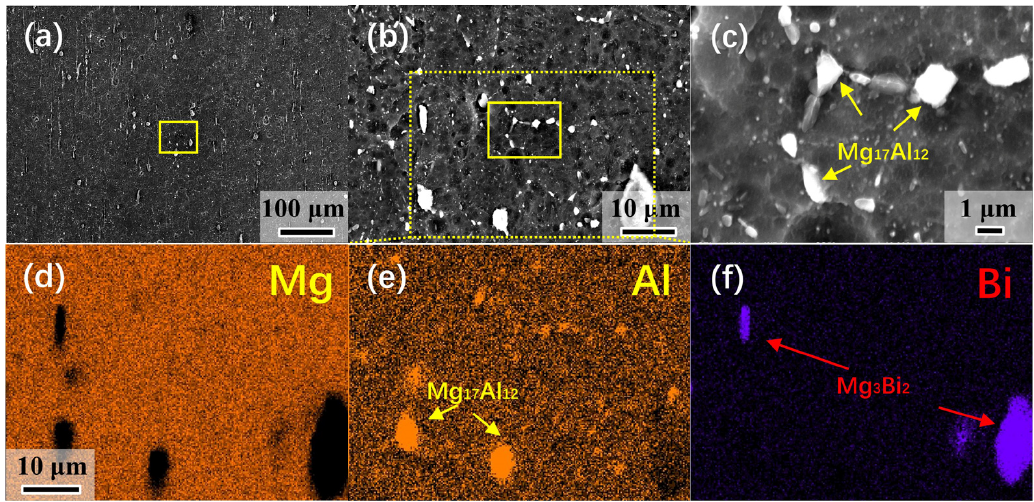
Figure 3. ( a – c ) Scanning electron microscopy (SEM) micrographs and ( d – f ) energy dispersive spectrometry (EDS) of as-rolled AB83 alloy. Arrows indicate Mg 3 Bi 2 and Mg 17 Al 12 second particles.